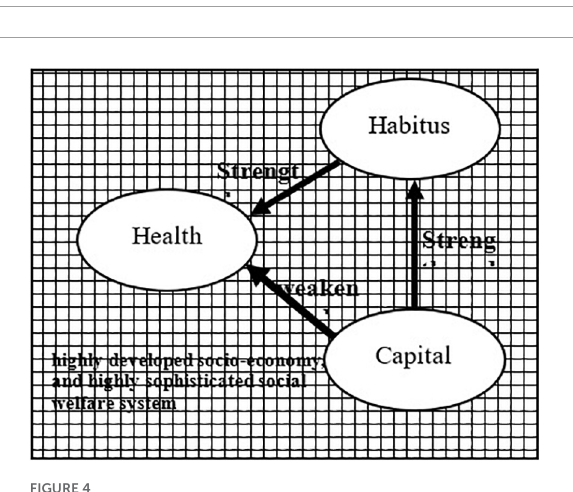
FIGURE4 Health field of the elderly in developed